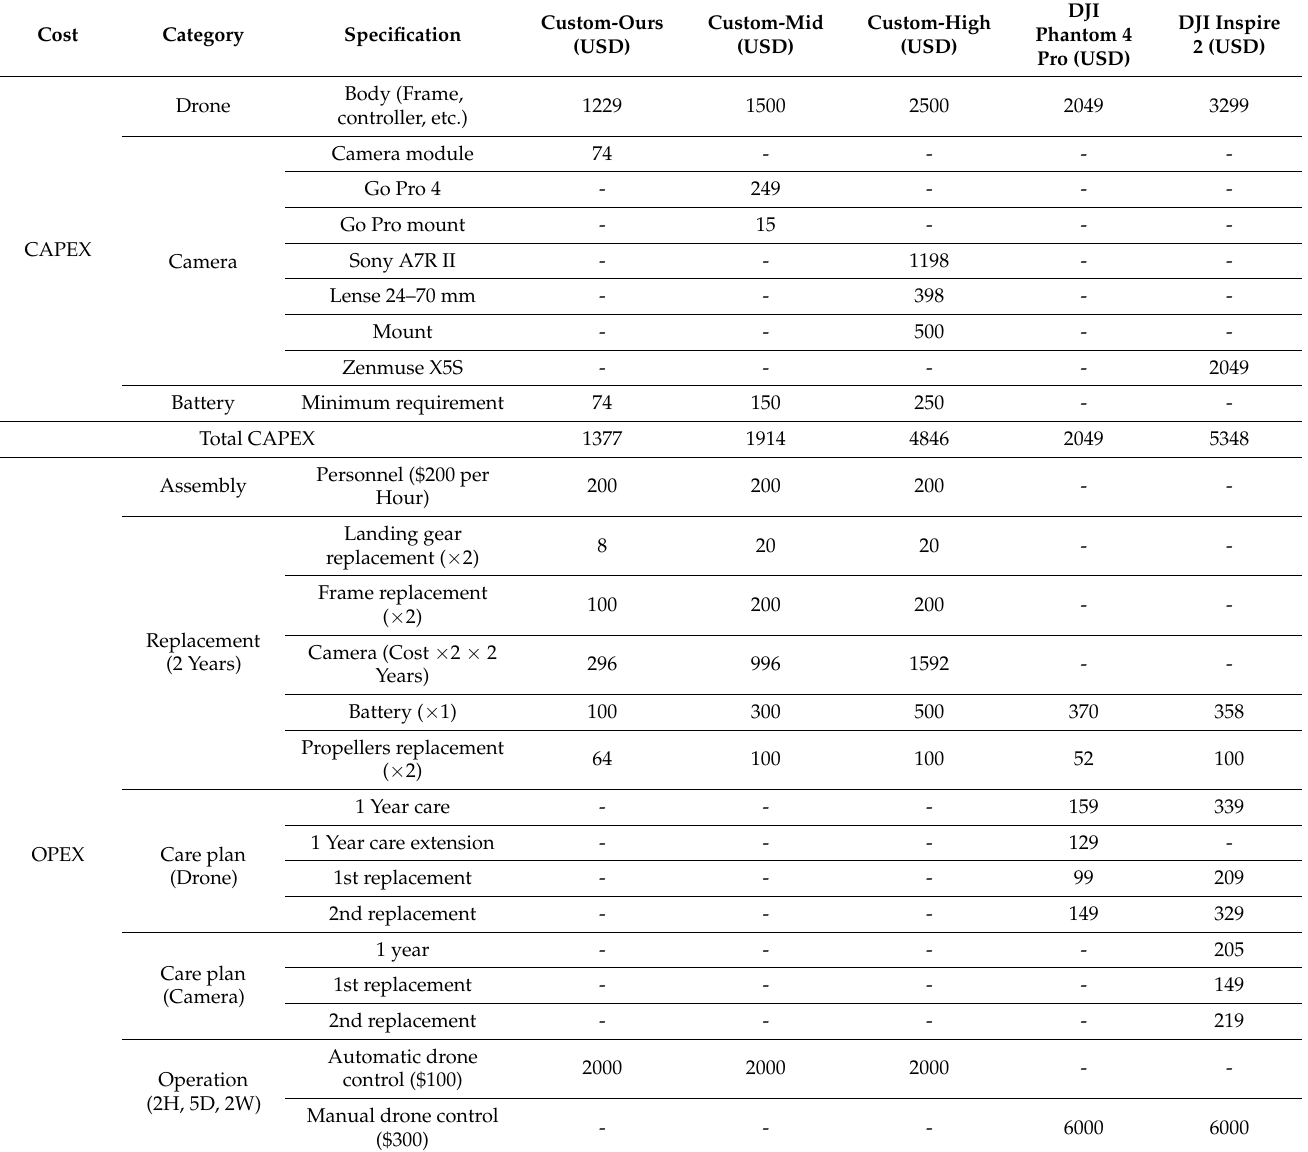
Table 2. Total Cost of Ownership of a Drone